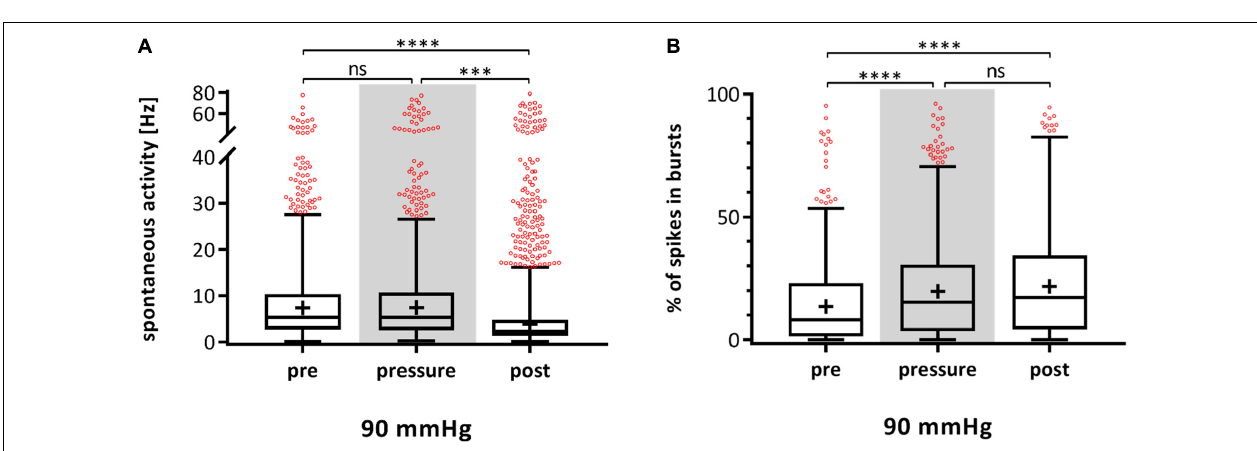
FIGURE 5 | Spontaneous activity and bursting behavior of RGCs in dark adapted retinae under 90 mmHg. The spontaneous firing frequency [Hz] (A) and the number of RGC spikes in bursts [%] (B) before (pre), during (pressure), and after (post) pressure stress of 90 mmHg is shown. The MEA experiments were carried out with dark adapted retinae under dim red light. Data are presented as box and whisker (min to max) plots. Outliers calculated by ROUT (Q = 0.1%) are shown as red circles. Mean values of the cleaned data are shown as + . Significant values are indicated by asterisks. Not significant values are labeled with ns. One-way ANOVA with post hoc Tukey’s test was performed with GraphPad Prism Software version 7. (A) F (2, 1922) = 12.79, p < 0.0001; (B) F (2, 1922) = 14.5, p < 0.0001. n retinae = 5, n cells = 262, n recordings = 90 (A) , 70 (B)